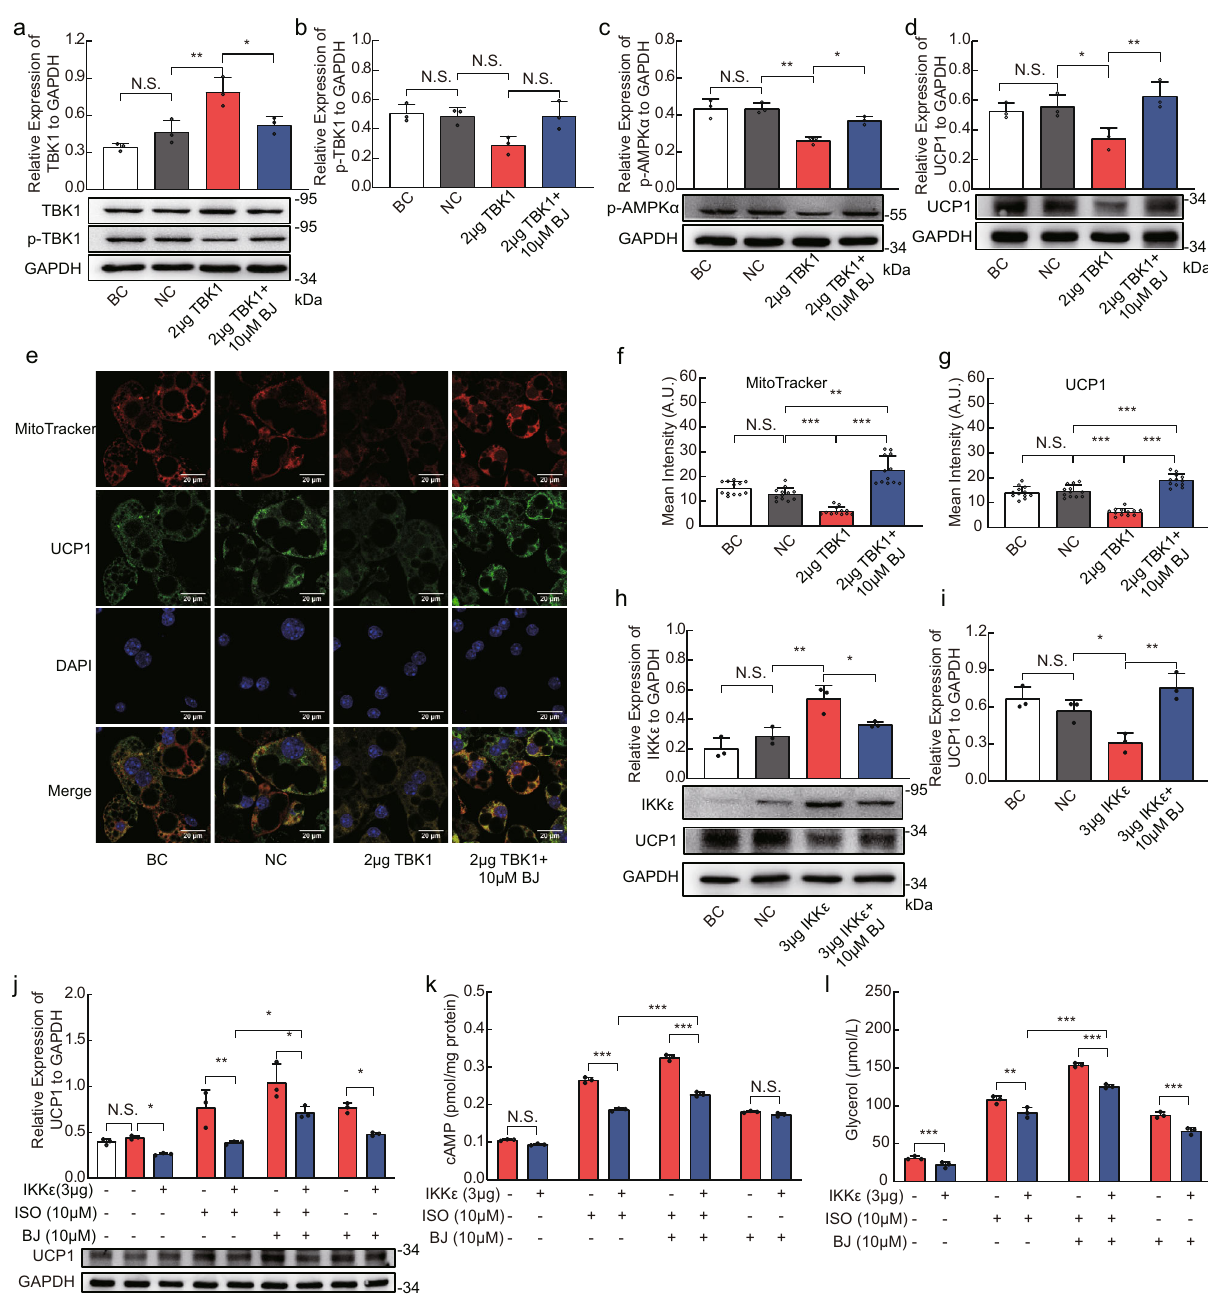
Fig. 8 BJ regulates TBK1 / AMPK / UCP1 pathway and IKK ε / adrenergic / cAMP pathway in 3T3-L1 adipocytes. a – d Effect of BJ on relative protein levels of TBK1, p-TBK1, p-AMPK α and UCP1 in differentiation of 3T3-L1 adipocytes transfected with TBK1 plasmid or empty vector. e Immuno fl uorescence staining of UCP1 (green), MitoTracker (red), and DAPI (blue) in differentiated 3T3-L1 adipocytes transfected with TBK1 plasmid or empty vector followed by treatment with or without BJ (scale bar = 20 µ m). f , g Quanti fi cation of fl uorescence intensity of MitoTracker and UCP1 ( n = 12 per group). h , i Effect of BJ on relative protein levels of IKK ε ( h ) and UCP1 ( i ) in differentiation of 3T3-L1 adipocytes transfected with IKK ε plasmid or empty vector. j Relative protein levels of UCP1 in differentiated 3T3-L1 adipocytes transfected with ISO or IKK ε plasmid or empty vector. k , l Measurement of cAMP levels ( k ) and Glycerol release ( l ) in differentiated 3T3-L1 adipocytes transfected with ISO or IKK ε plasmid or empty vector. Data are expressed as mean ± SD. NS not signi fi cant, * P < 0.05, ** P < 0.01, *** P <